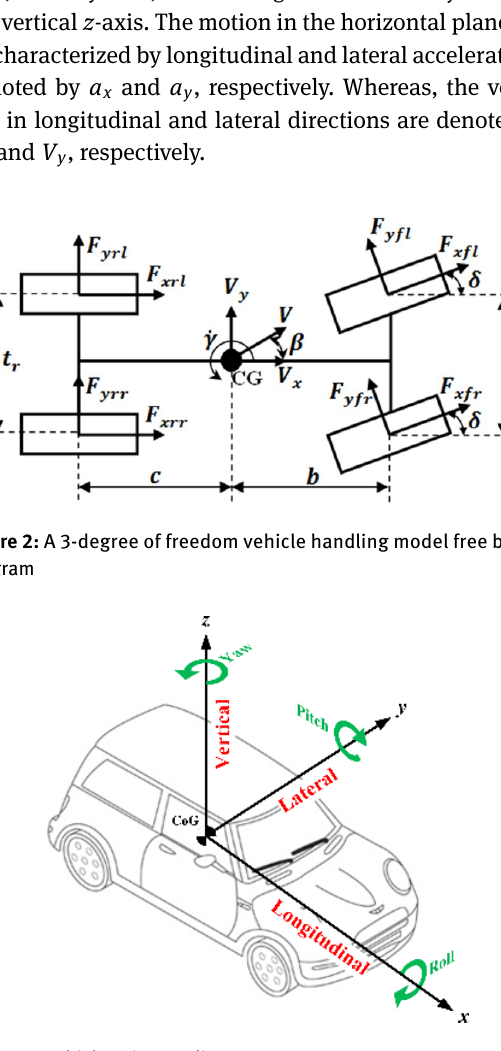
Figure 3: Vehicle axis coordinate